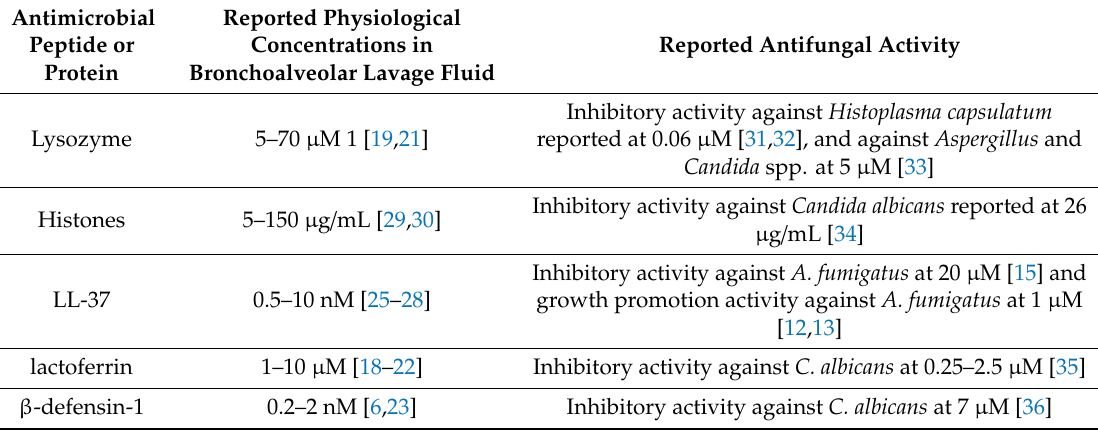
Table 1. Summary of physiological concentrations in vivo and reported antifungal activity of the antimicrobial peptides and proteins selected for